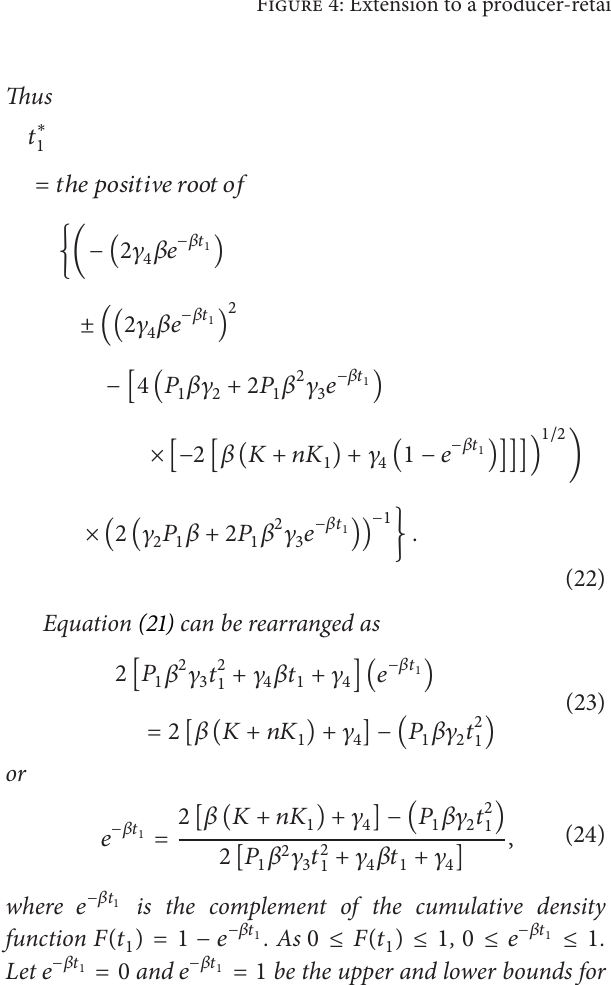
Figure 4: Extension to a producer-retailer integrated production-shipment